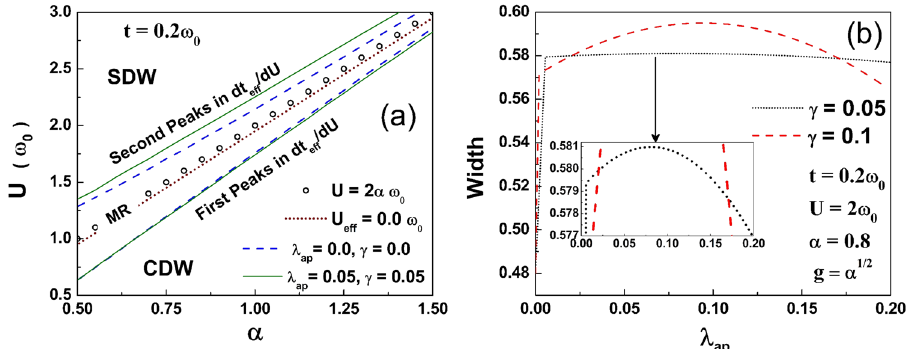
Figure 4. ( a ) Phase diagram in α − U plane determined from the peaks in dt eff / dU . MR represents metallic region ( b ) Peak-to-peak width from dt eff / dU -plot as a function of λ ap for two values of γ